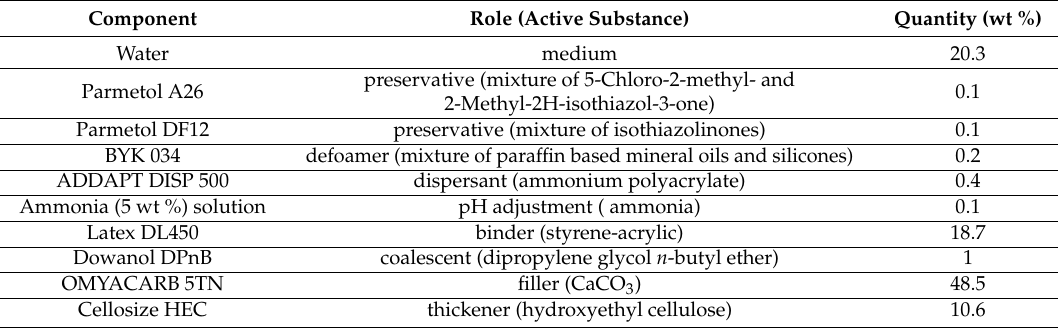
Table 1. The formulation of waterborne